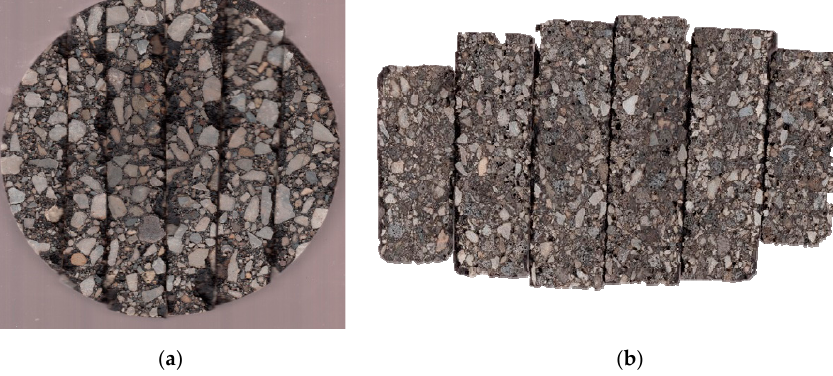
Figure 7. Cut surface of core sample; ( a ) top-down view and ( b ) inside of core.